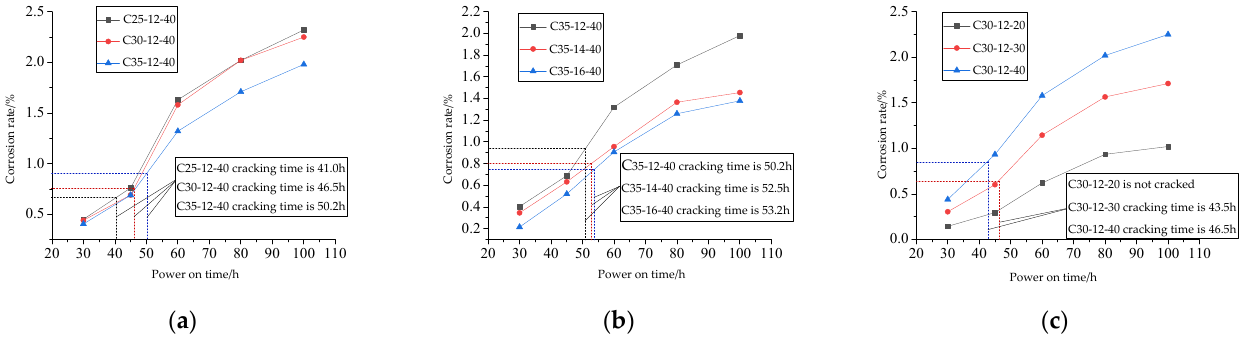
Figure 3. Change curve of corrosion rate of reinforcement. ( a ) Different concrete strength grades; ( b ) Different reinforcement diameters; ( c ) Different energizing voltage.